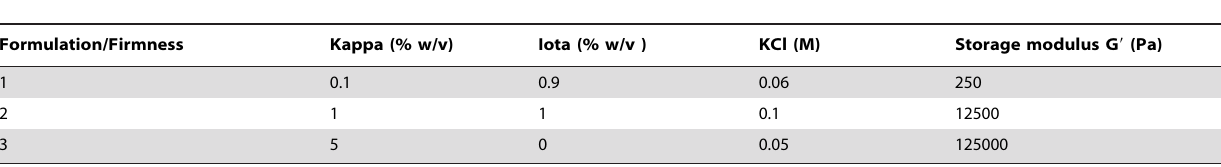
Table 1. Formulations of gel